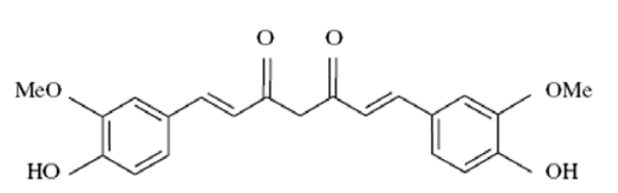
Figure 1. Structure of